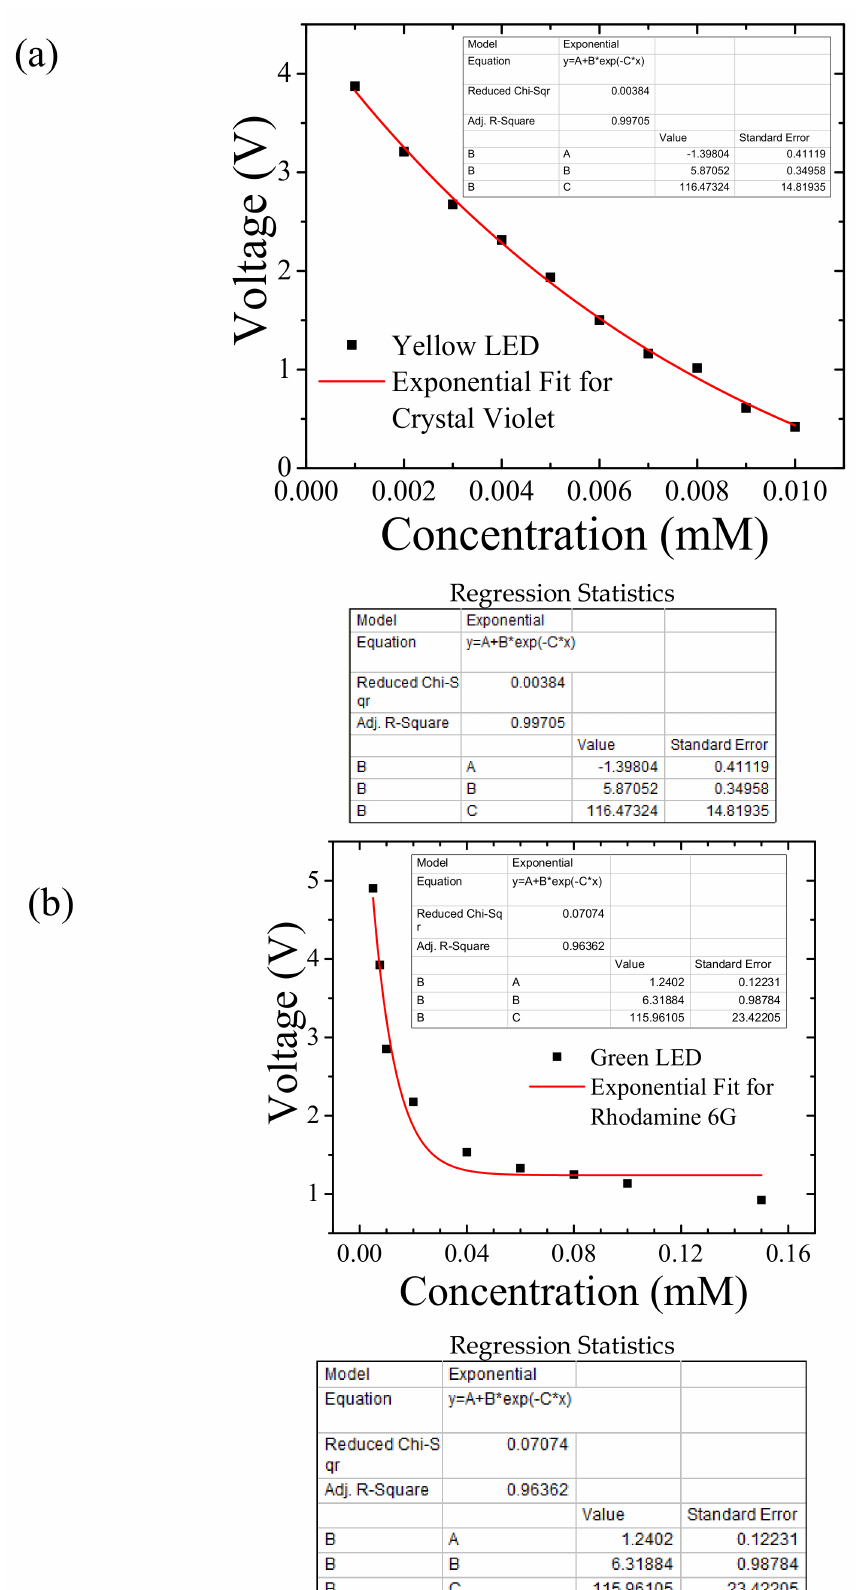
Figure 3. Photodiode output voltage (averaged over 500 voltage readings) as a function of concentration of ( a ) Crystal Violet synthetic dye using the yellow LED and ( b ) rhodamine 6 g fluorescent dye using the green LED. The data points are fitted to an exponentially decaying equation model via a three-variable regression analysis to find molar absorption